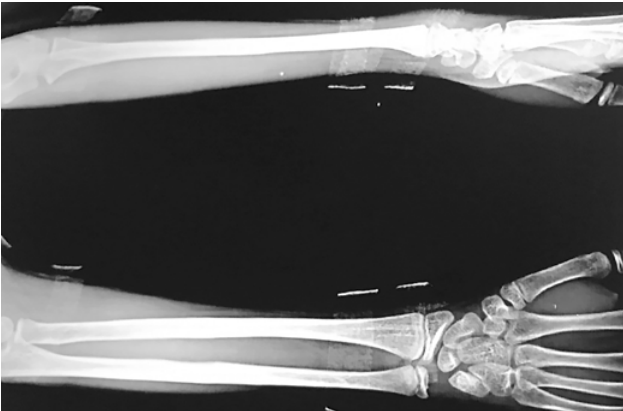
Fig 8 : X-ray of forearm after implant